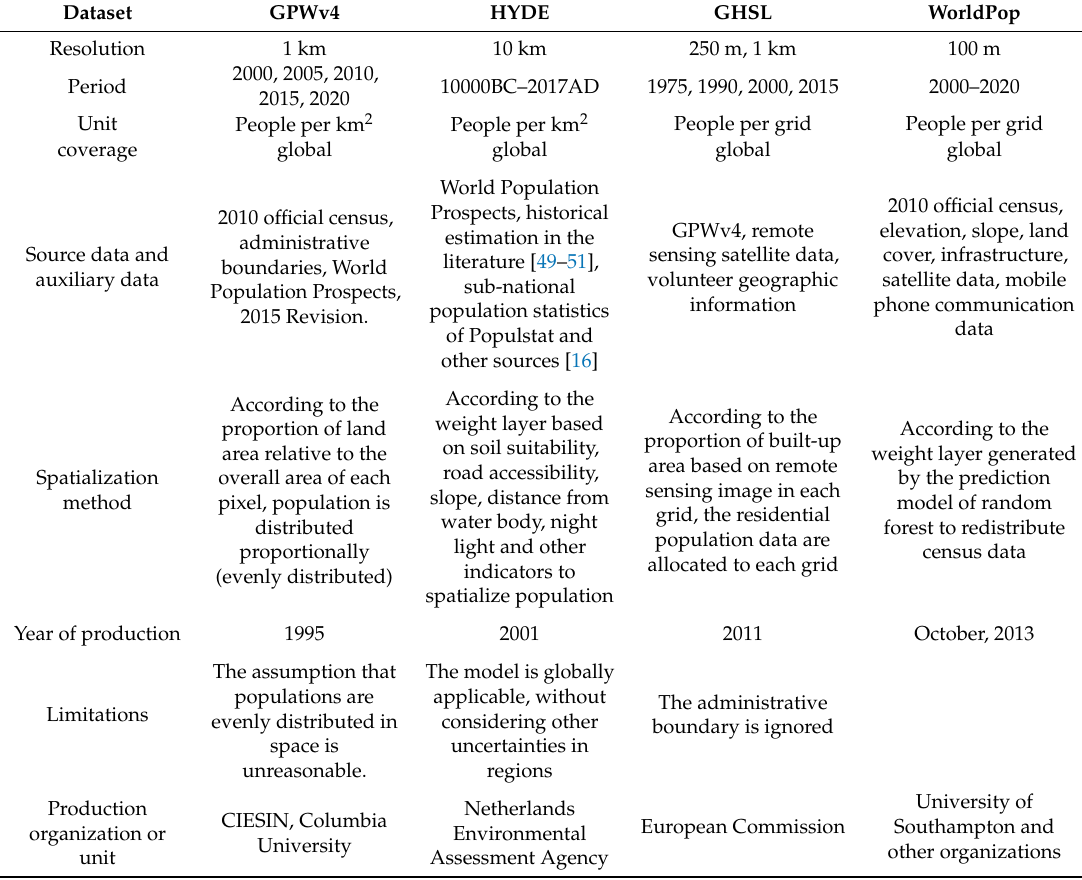
Table 2. Basic information of spatial population